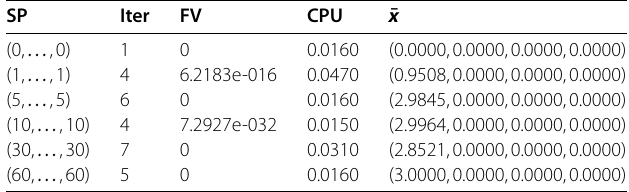
Table 6 Numerical results for Example